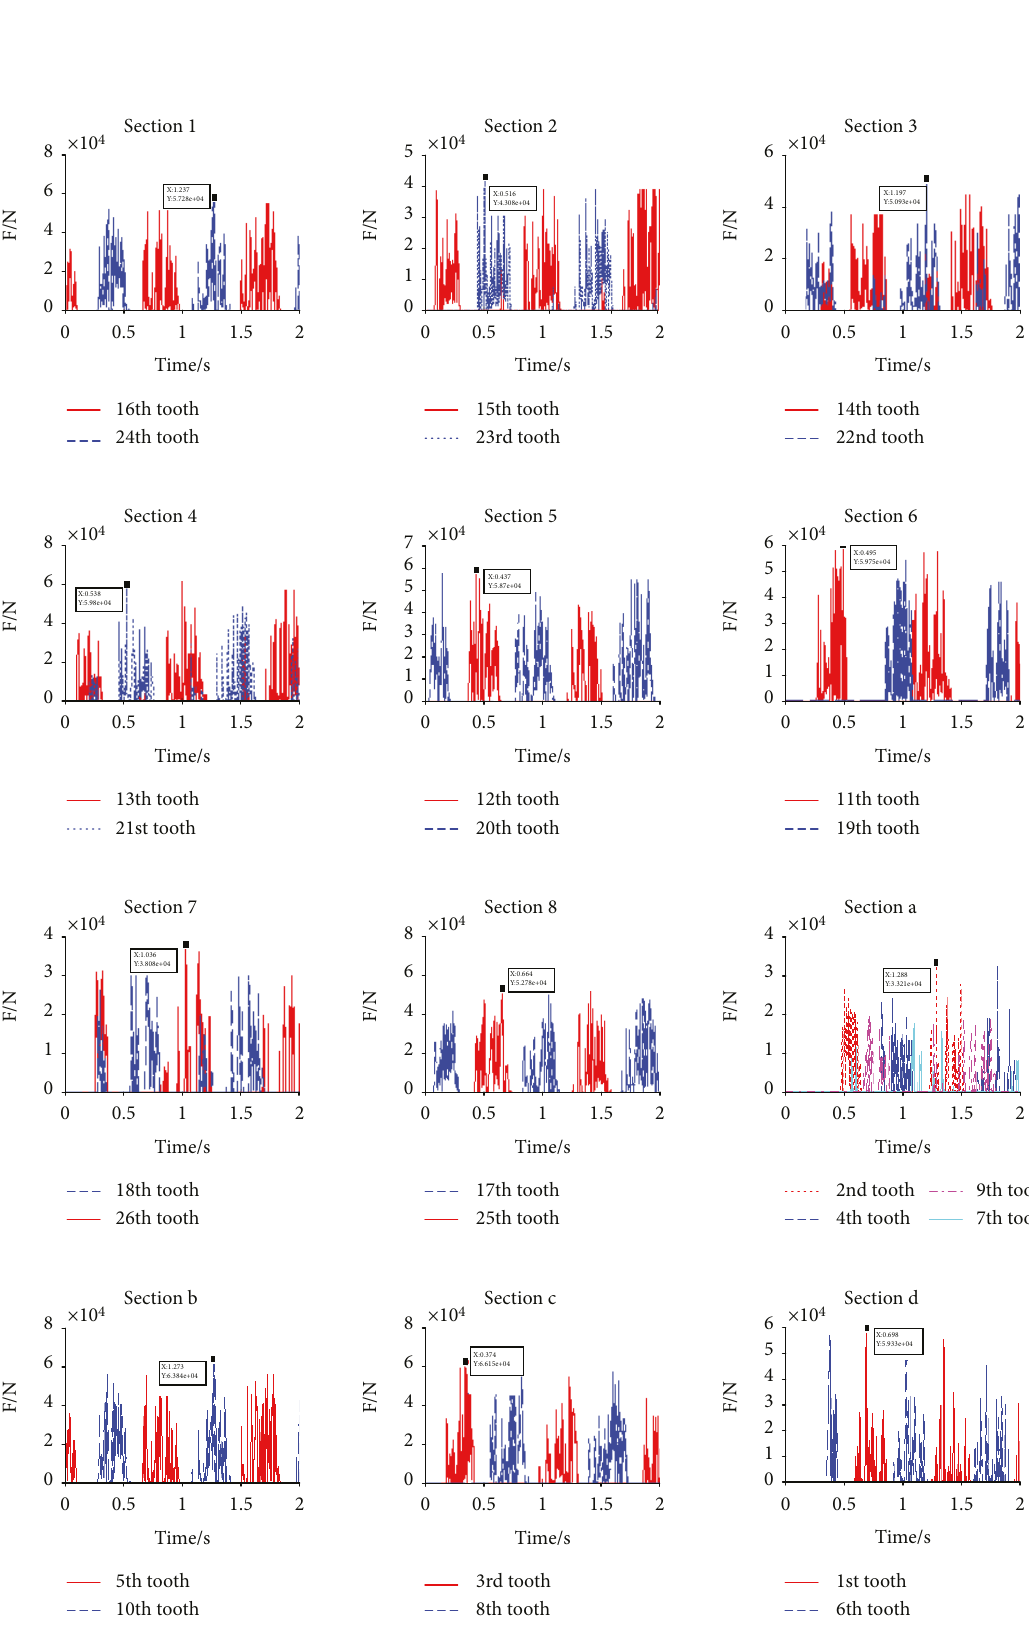
Figure 10: The cutting